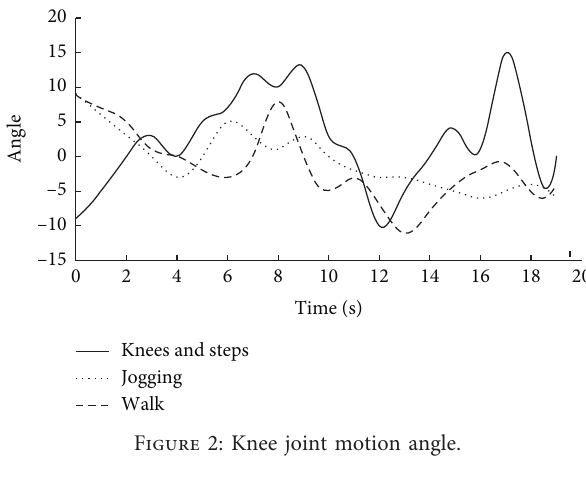
Figure 2: Knee joint motion angle.